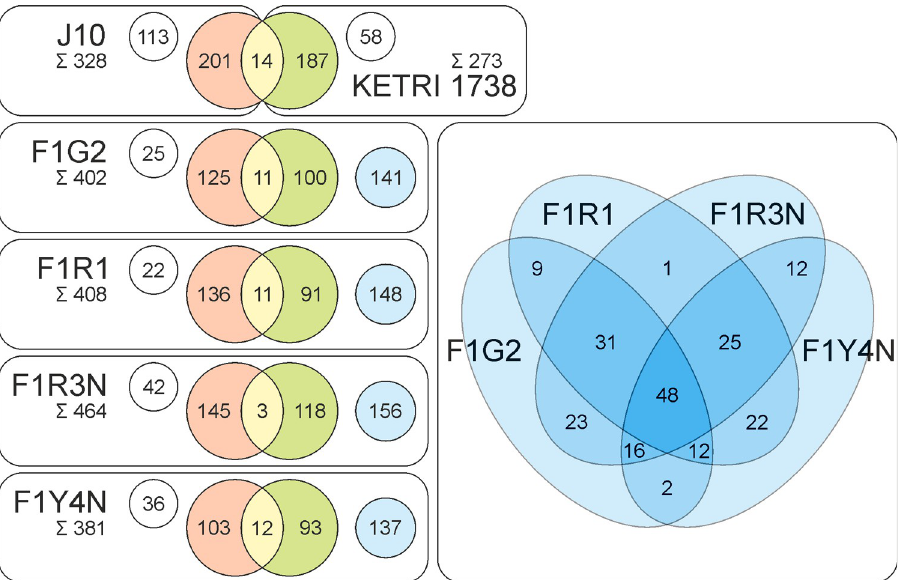
Fig 3. Inheritance of parental VSG s in hybrid progeny clones. Top: 587 VSG s were found in parents J10 (328 VSG s) and 1738 (273 VSG s) with 14 shared; those also found in one or more progeny clones are in red and green respectively, while strain-specific VSG s not found in progeny clones are shown in white circles. Bottom: VSG s inherited by the four hybrid progeny clones; parental origin is indicated by red (J10) and green (1738). Additional VSG s not found in either parent are shown in white circles if clone-specific, or blue circles if shared by one or more hybrid clones; the Venn diagram (right) expands the blue circle total to show the number of VSG s shared between individual hybrid clones.